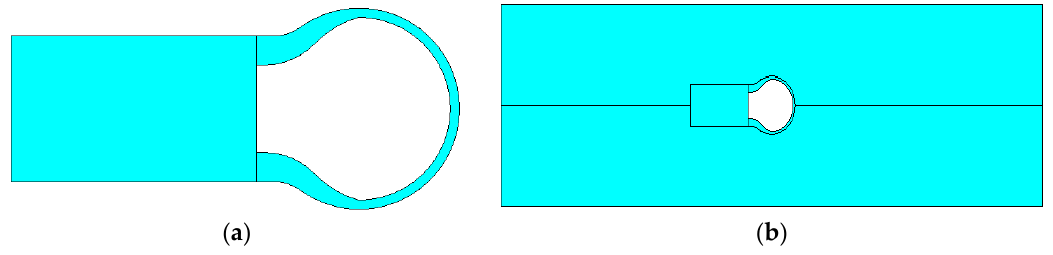
Figure 6. ANSYS simulation diagram. ( a ) The model of the micro bubble; ( b ) The micro bubble is fixed in the middle of two PDMS diaphragms.